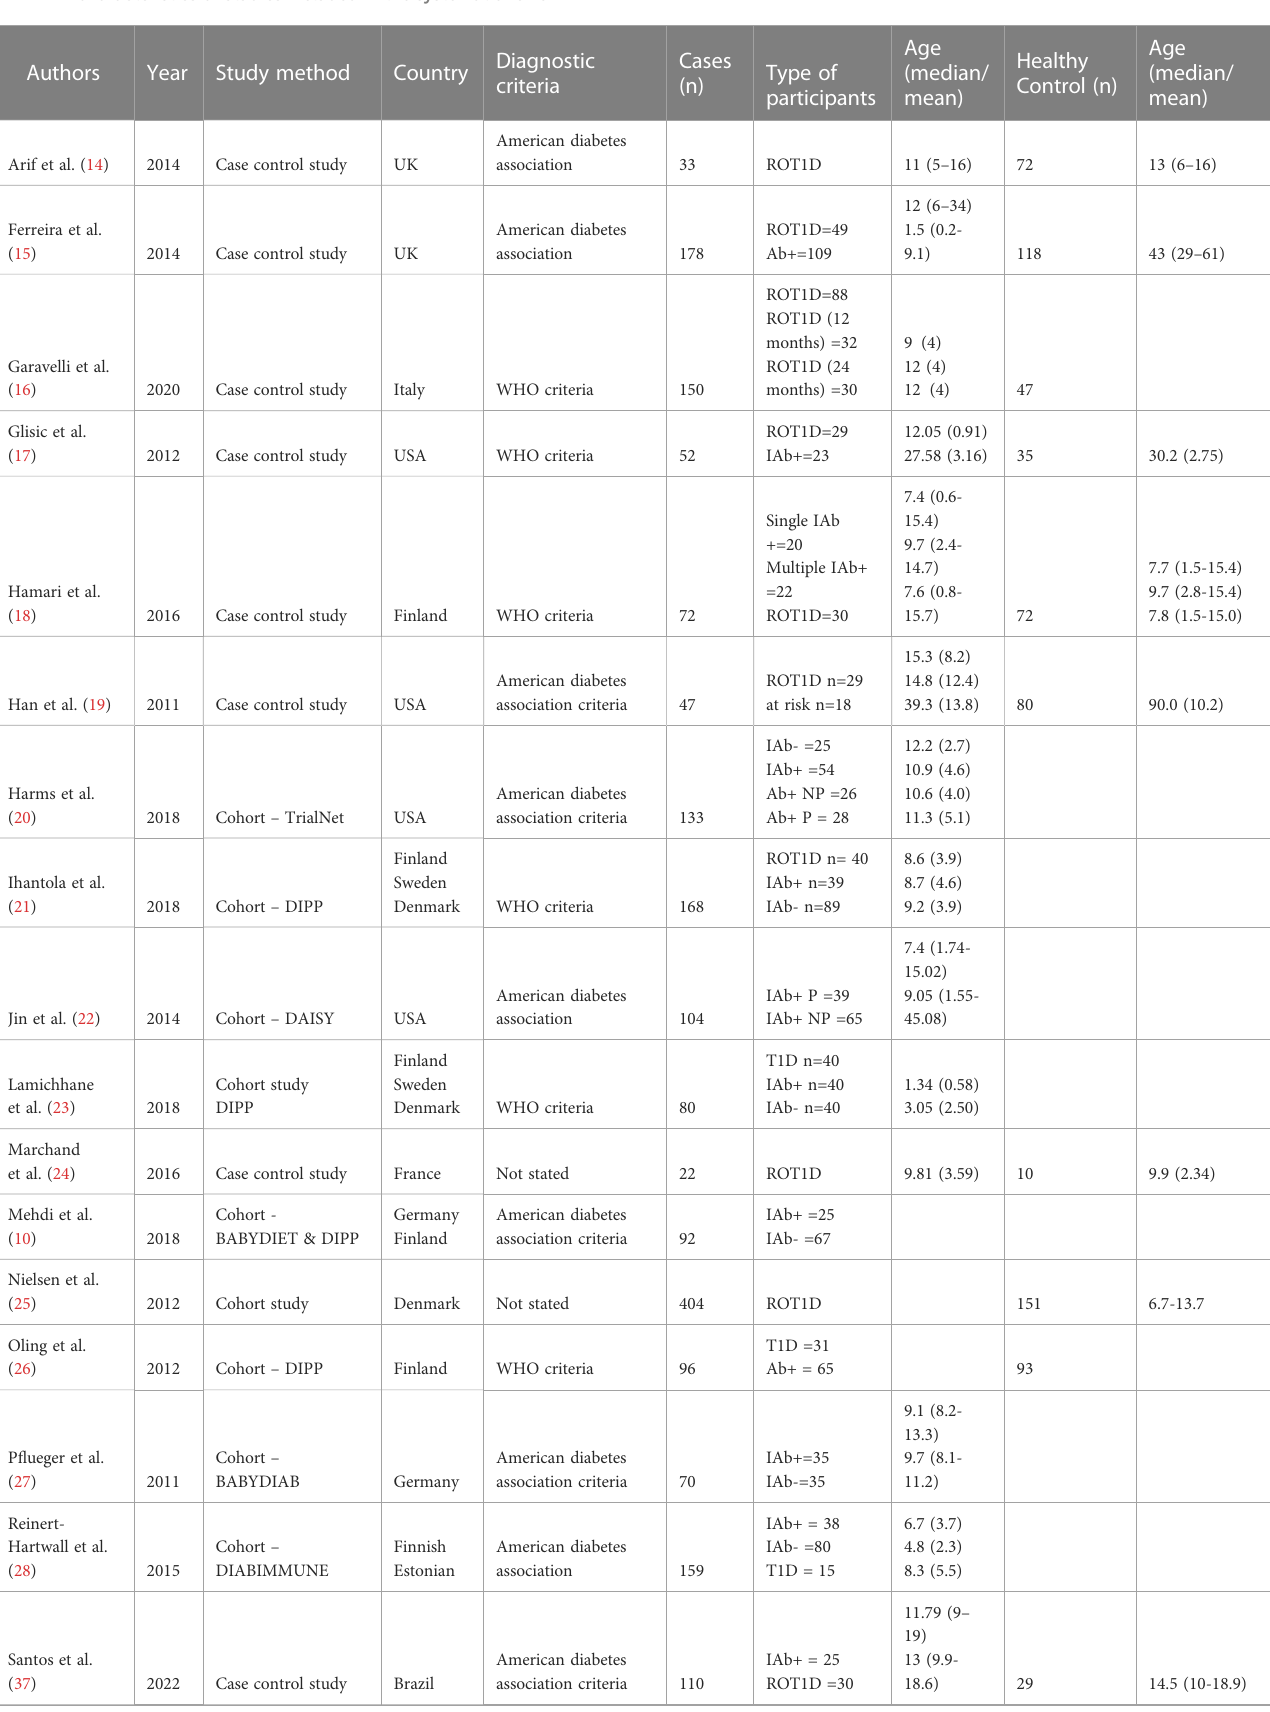
TABLE 1 Characteristics of studies included in the systematic